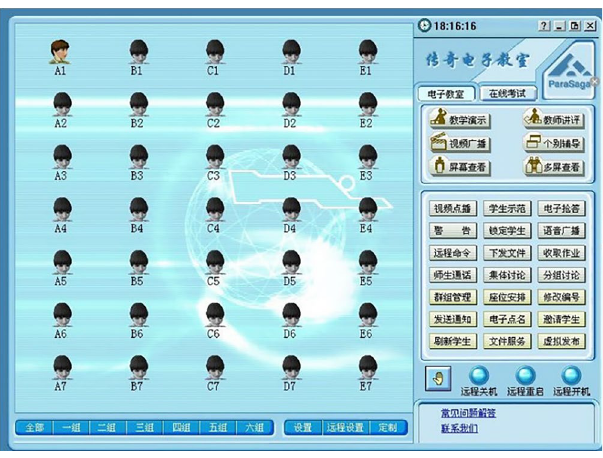
Figure 2. Teachers can share teaching resources, interact with students, share their computer interface with each student’s computer in real time, and monitor the tabs and programs displayed on their screen via ParaSaga EClass.